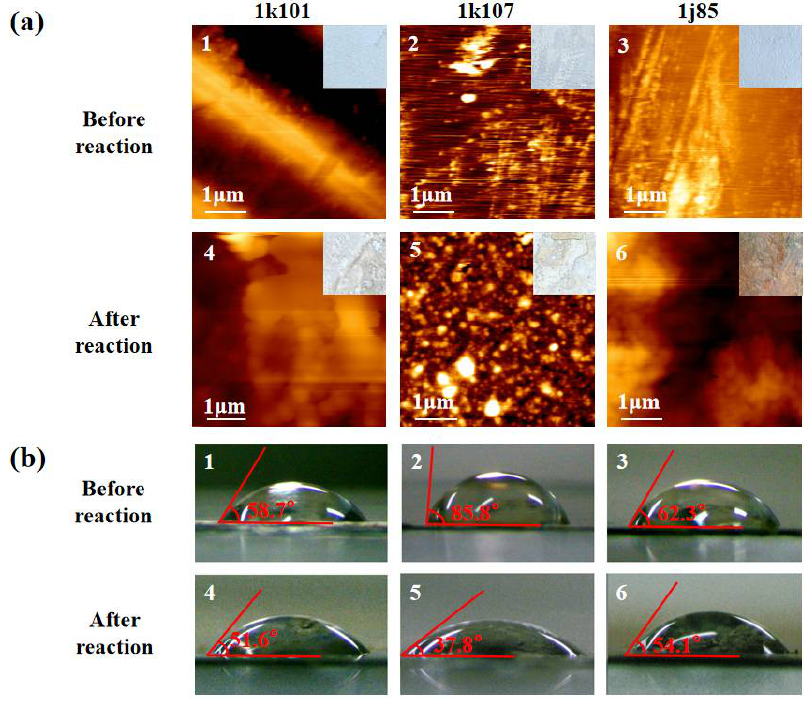
Figure 6. The surface features of the 3 kinds of Fe-based sheets before reaction and after being reused 5 times; ( a ) the AFM photos; ( b ) the images of the contact angles.